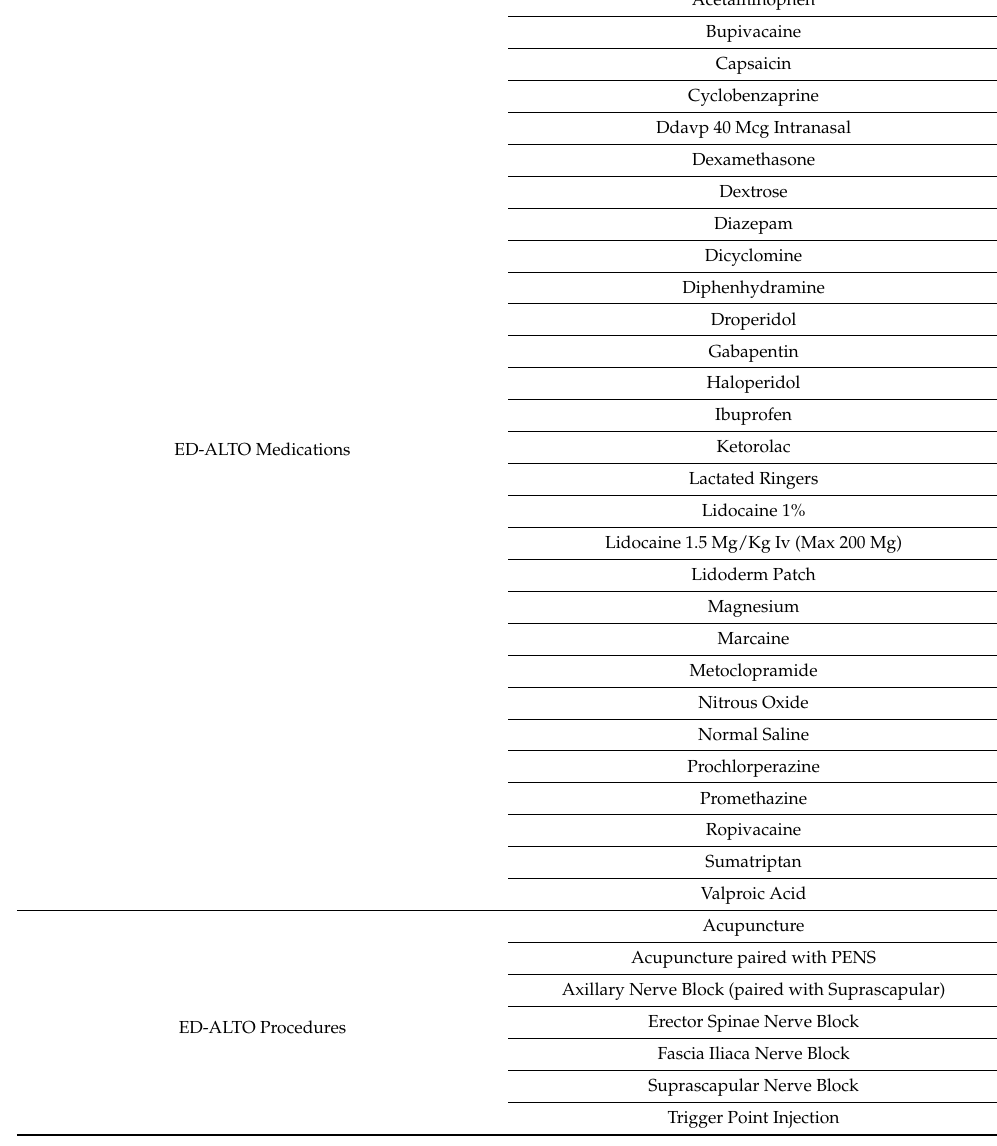
Table A1. List of ED-ALTO Medications and